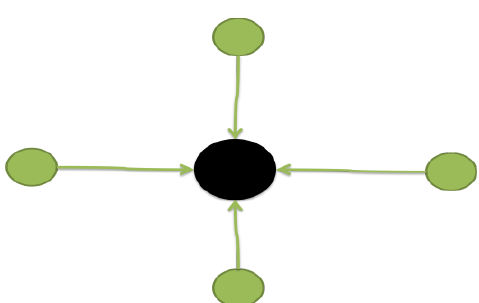
Figure 7. Illustration of a merging event.